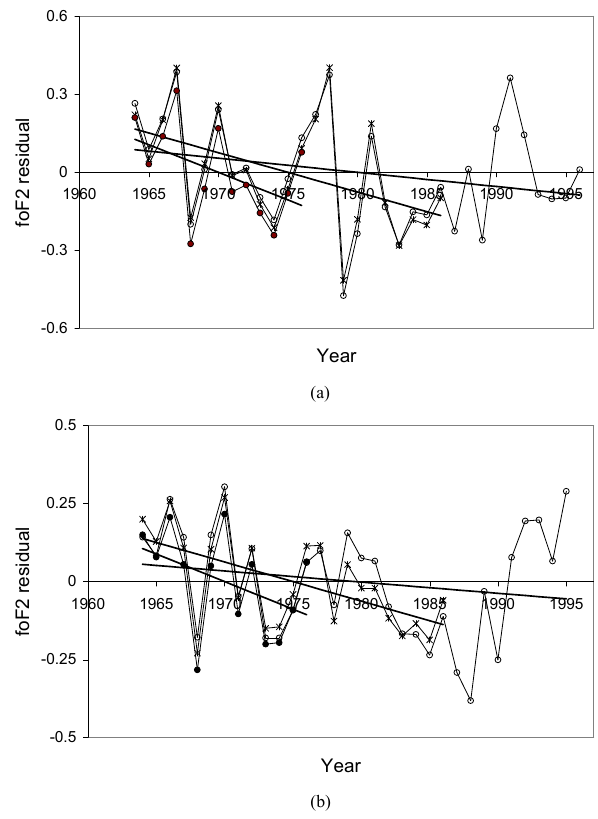
Figure 5. Time series of foF2 residuals and long term trend (enhanced line) considering Fig. 5. Time series of fo F2 residuals and long term trend (enhanced solar cycle 20 (solid circle), solar cycles 20+21 (asterisk) and solar cycles 20+21+22 (empty cicrcle) for noon values (a) in September at Slough and (b) in April at Argentine line) considering solar cycle 20 (solid circle), solar cycles 20+21 Islands. (asterisk) and solar cycles 20+21+22 (empty cicrcle) for noon val- ues (a) in September at Slough and (b) in April at Argentine